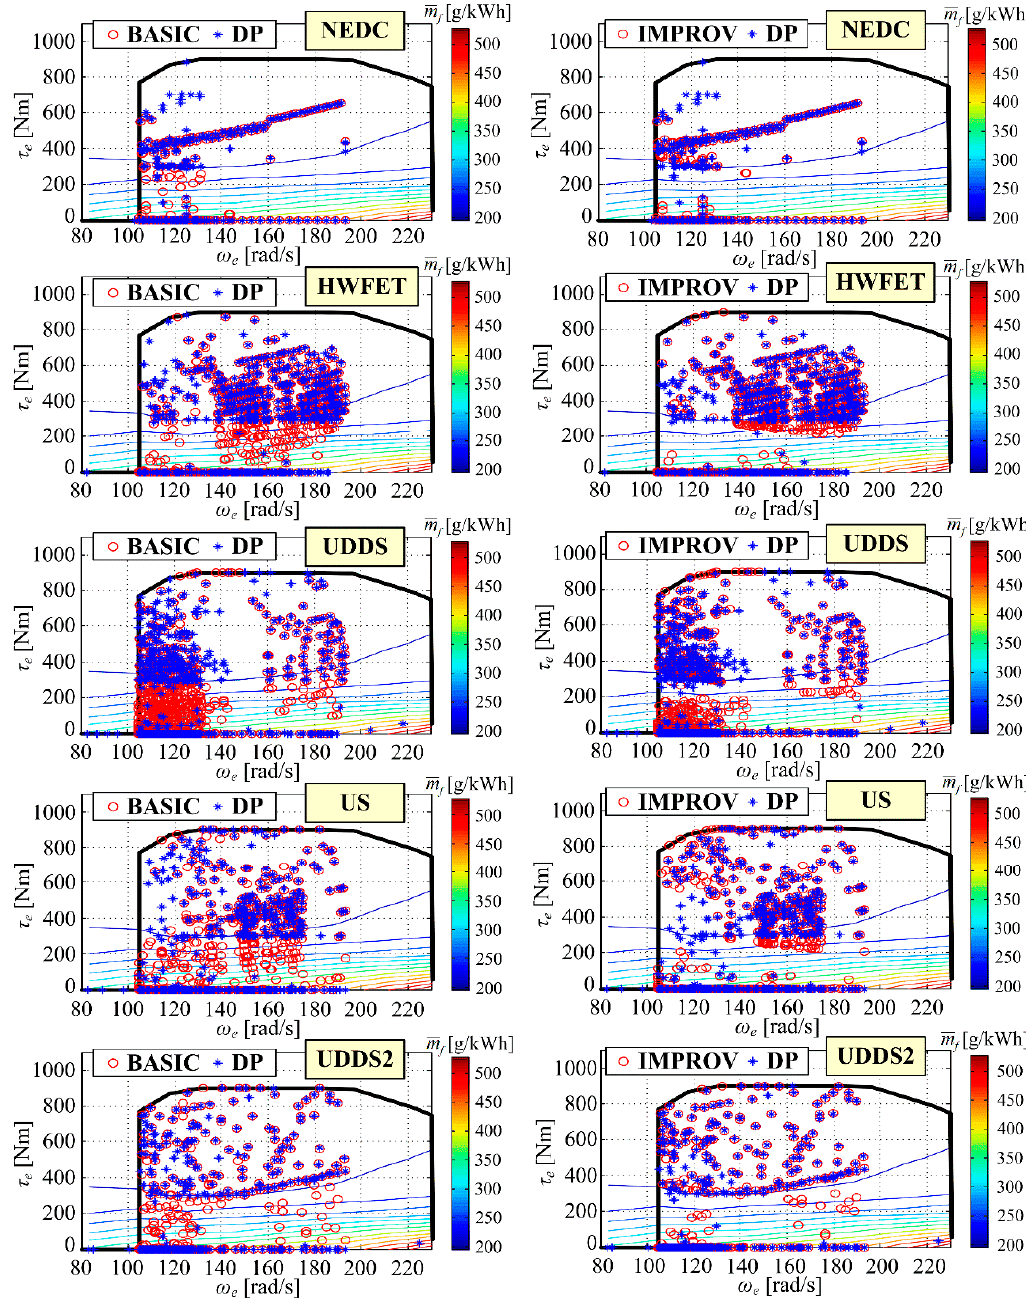
Figure 13. ICE operating points of BASIC and IMPROV control strategies presented parallel to optimum operating points obtained by DP optimization for different driving cycles.